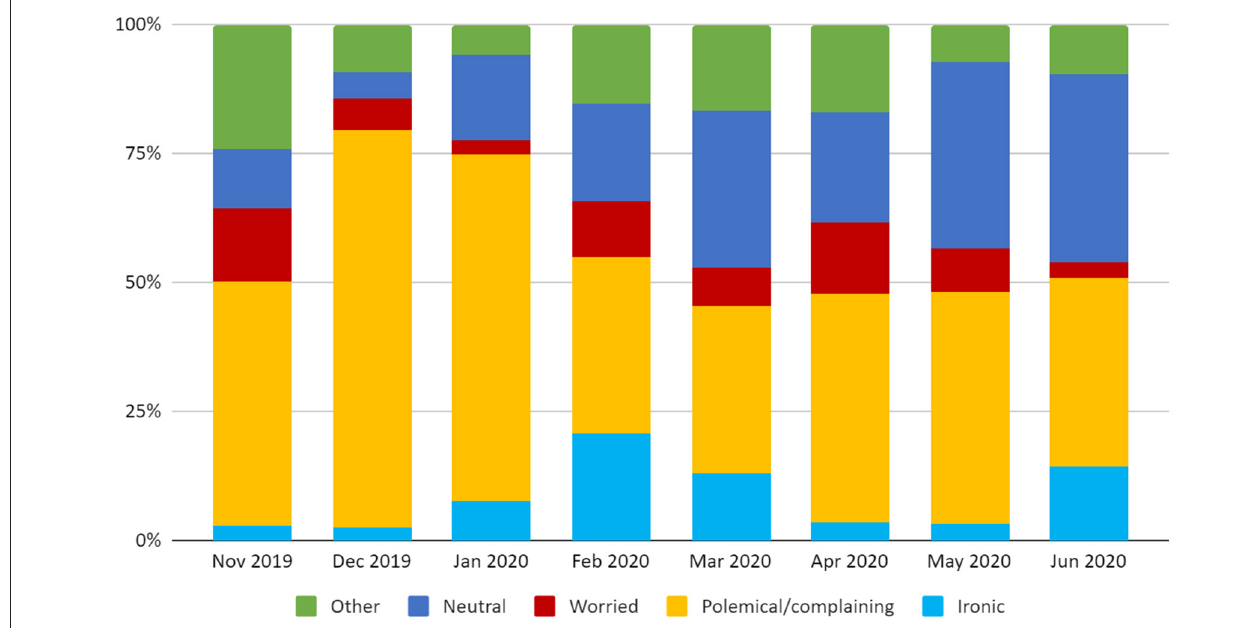
FIGURE 3 | Monthly distribution of the tweets’ tone of voice in the study period.